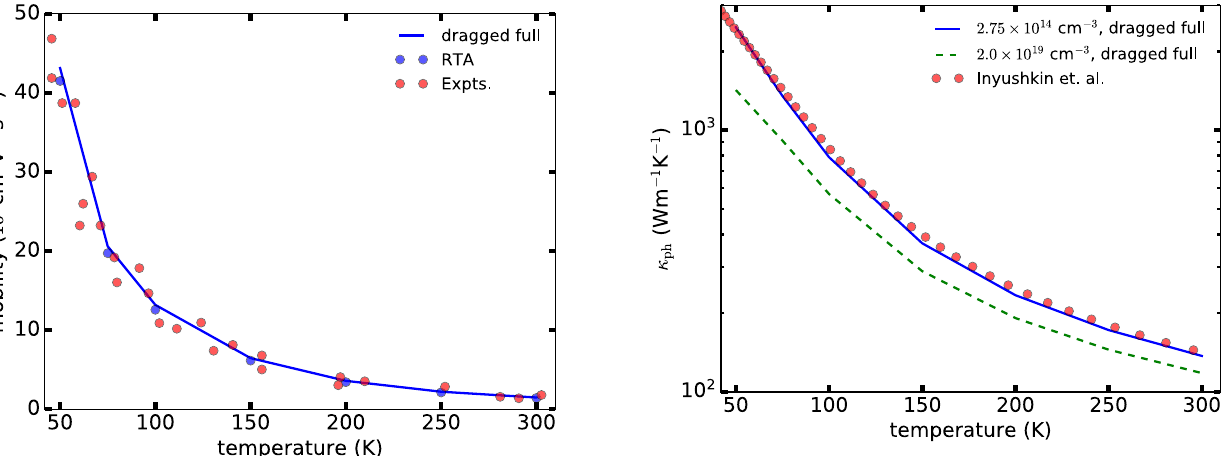
Fig. 6 Temperature dependence of the phonon thermal con- ductivity of silicon for n -type carrier concentrations of 2.75 × 10 14 and 2 × 10 19 cm − 3 . The red circles are measurements on high purity samples with natural isotopic mix 57